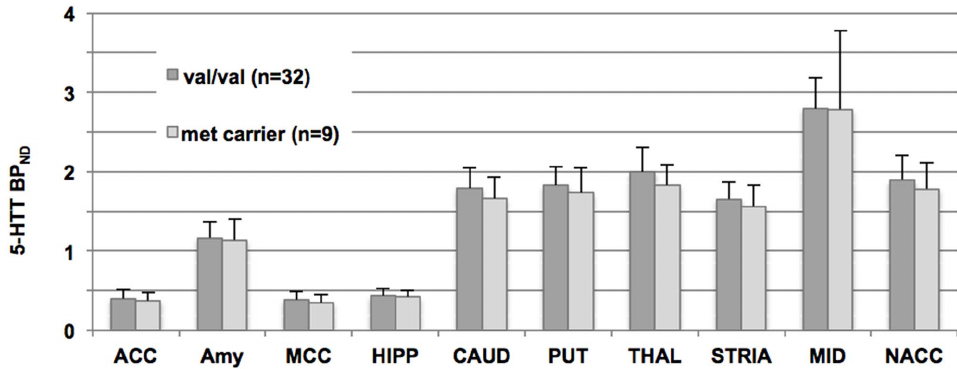
Figure 2. Bar chart plotting serotonin transporter binding potential (5-HTT BP ND ) according to BNDF Val66Met genotype status. Values at the y-axis represent 5-HTT BP ND in pooled healthy subjects and depressive patients. Binding potential is separated for val/val and met- carriers, respectively, x-axis shows regions of interest. Because healthy subjects and depressive patients were pooled here, regions do, but values do not correspond to table 3. ACC: anterior cingulate cortex, AMY: amygdala, MCC: medial cingulate cortex, HIPP: hippocampus, CAUD: caudatum, PUT: putamen, THAL: thalamus, STRIA: striatum, MID: Midbrain, NACC: nucleus accumbens.